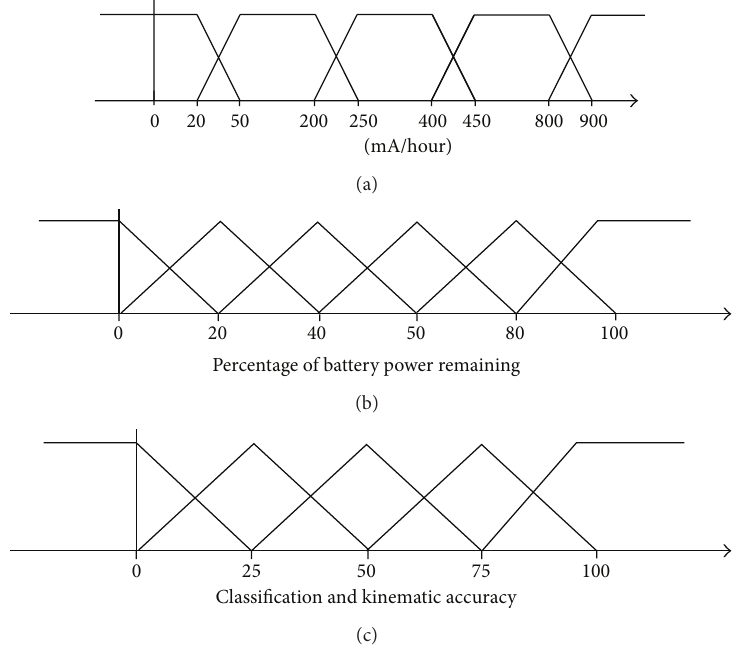
Figure 6: Antecedent membership functions used for the wake-up classification’s fuzzy game and in the sensor tracking and classification fuzzy